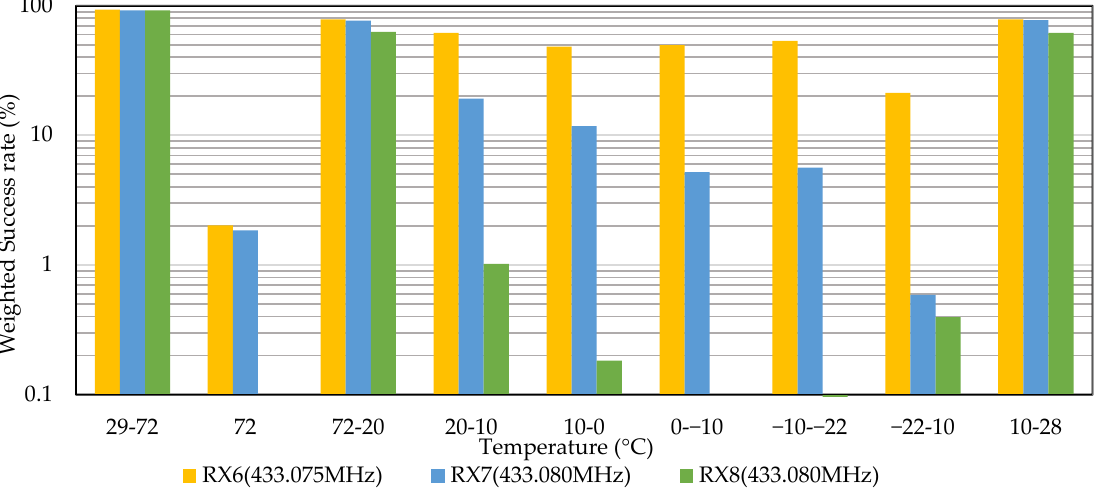
Figure 17. Summary of temperature dependence test of receivers in PeTT chamber.